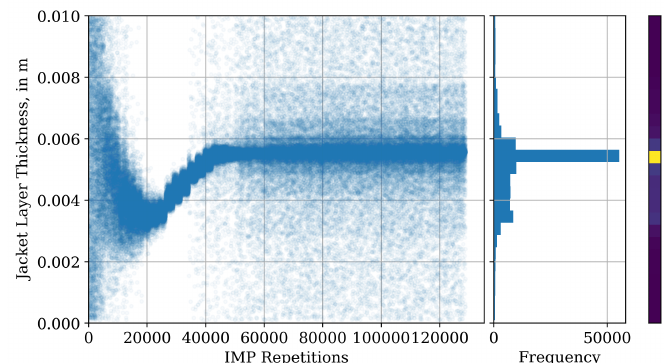
Figure A1. Demonstration of how parameter information is condensed. Left side shows the parameter development for the jacket layer thickness during T b . The centre plot shows the frequency of the sampled parameters, distributed over 25 bins. The colour bar at the right side is a heat map ribbon of the histogram in the centre, with yellow being the highest frequency and blue the lowest.